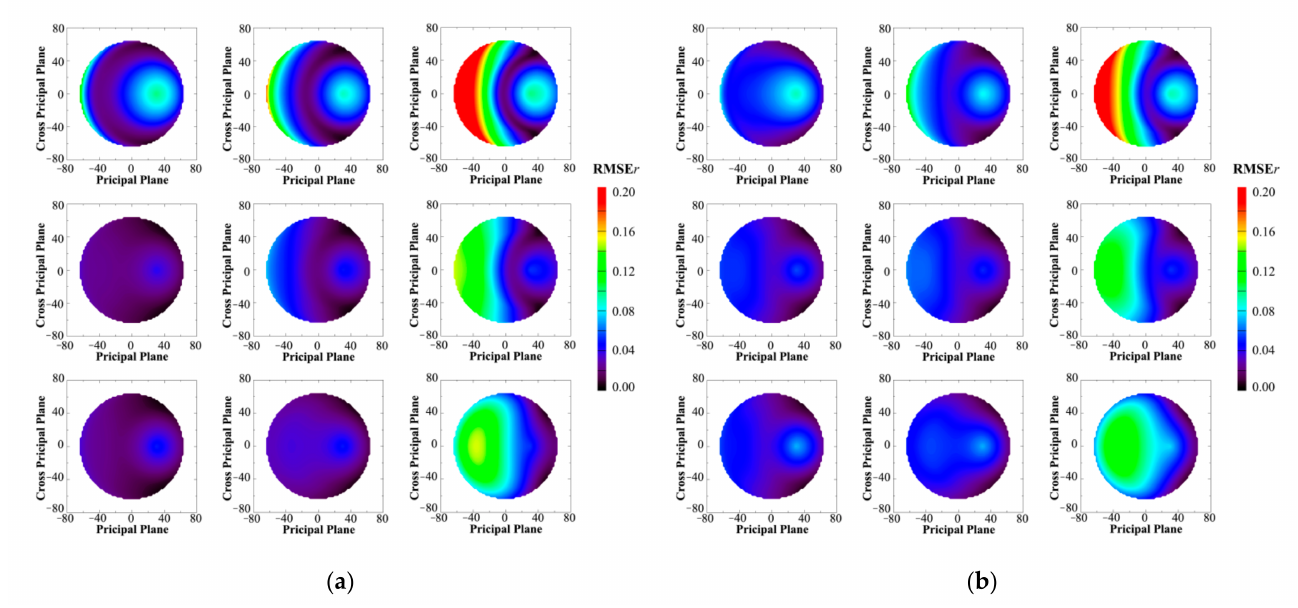
Figure 9. The distribution of RMSE r between MODIS albedo and albedo retrieval from different BRDF archetypes and directional reflectance in the whole viewing hemisphere with a solar zenith angle of 30 ◦ in the red ( a ) and NIR ( b ) bands.